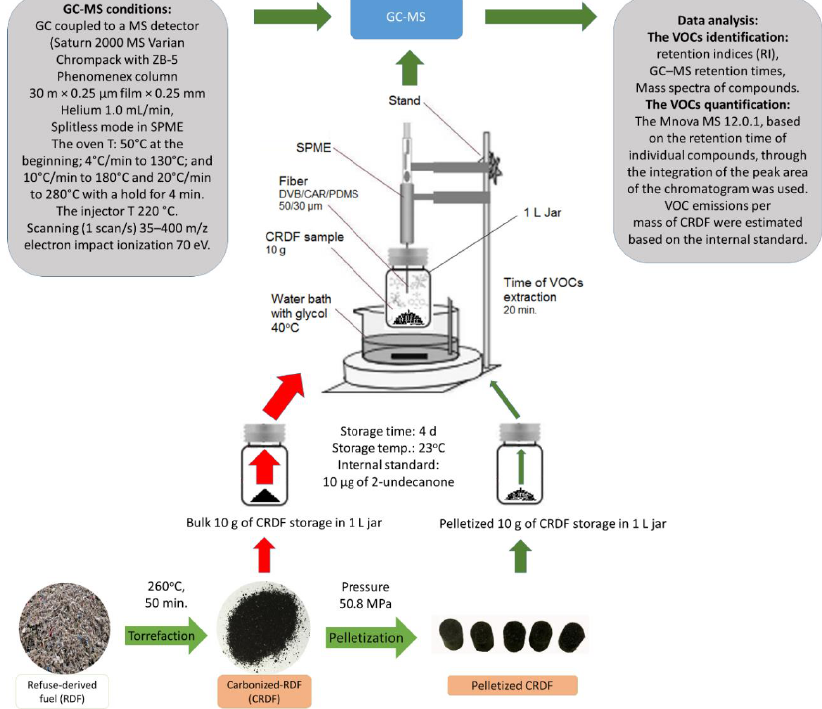
Figure 1. The experimental procedure used to measure VOC emissions from stored carbonized refuse-derived fuel. GC-MS—gas chromatography with mass spectrometry, GC—gas chromatography, MS—mass spectrometry, SPME—solid-phase microextraction, VOCs—volatile organic